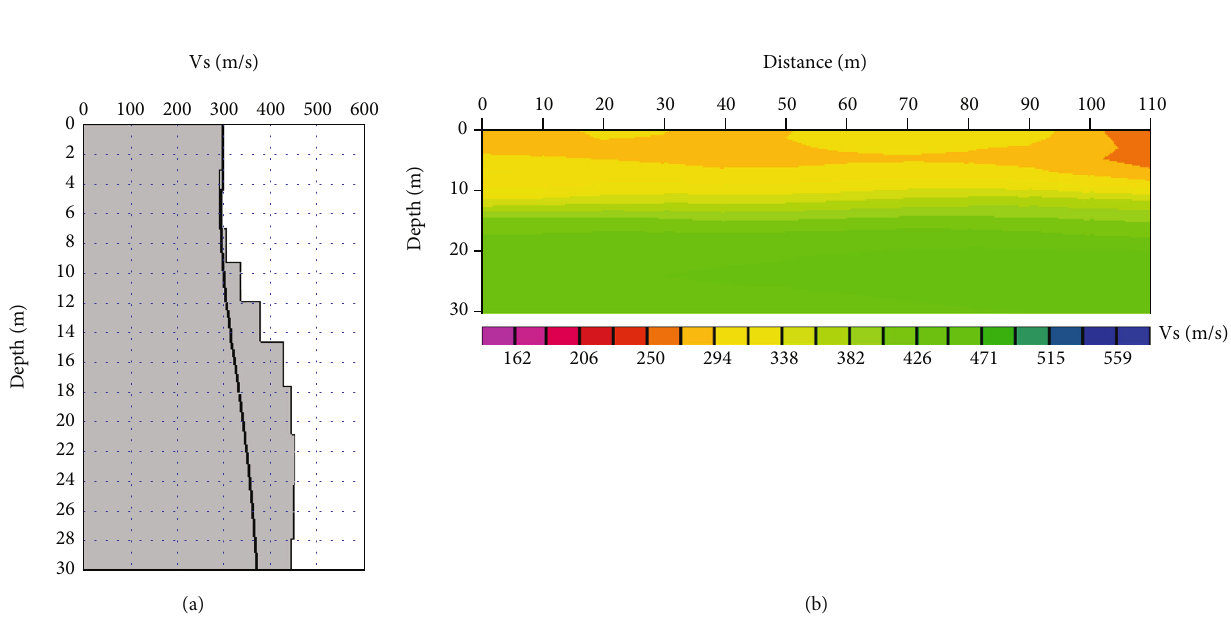
Figure 11: (a) MASW 4 1D Vs pro fi le and (b) MASW 4 2D Vs